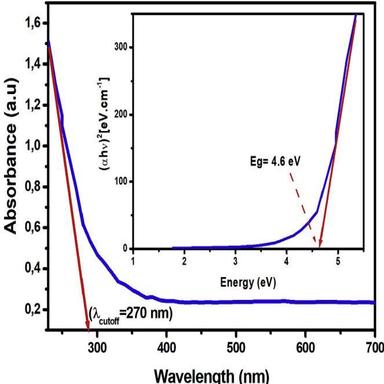
Absorption spectrum and optical band gap of tetrakis(thiourea)cobalt chloride crystal.